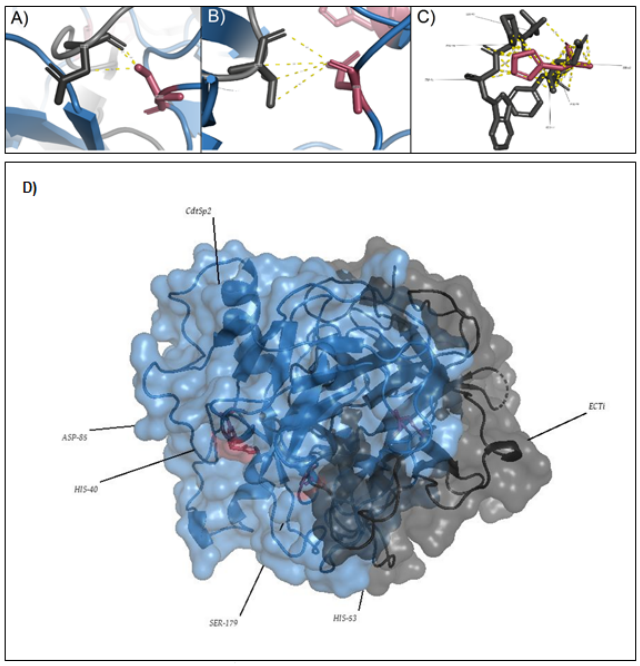
Figure 10. Interaction between EcTI with the amino acid residues of the Active Site of Cdtsp-2. The bonds are 0.9 Å to 3.5 Å. ( A ): His 188. ( B ): Asp 92. ( C ): His 43. ( D ): Interaction between EcTI and Cdtsp-2.